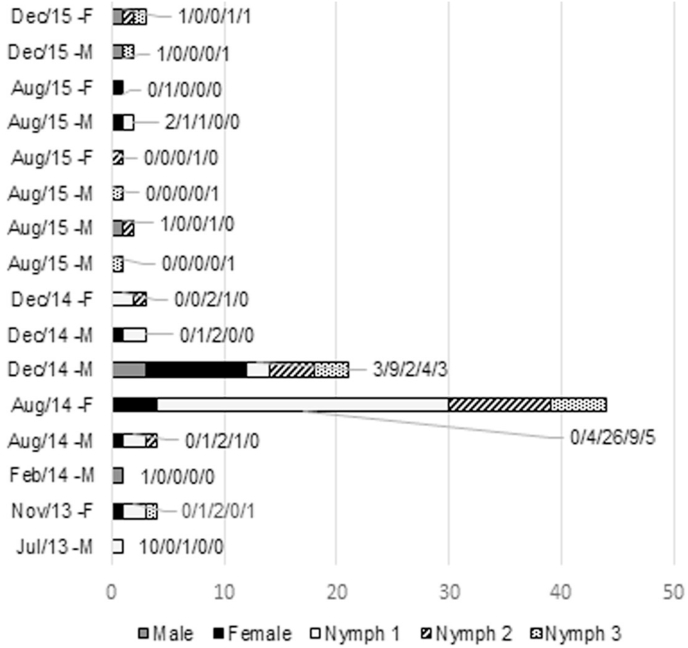
Distribution of Gyropus (m.) martini stages on Trinomys iheringi rodents. Host sex (F = female, M = male) and capture months (Aug = August, Dec = December, Feb = February, Jul = July, Nov = November) in Ilha Grande State Park, RJ, Brazil. The numbers along the x axis represent the number of lice life stages: male/female/nymph 1/nymph 2/nymph 3.